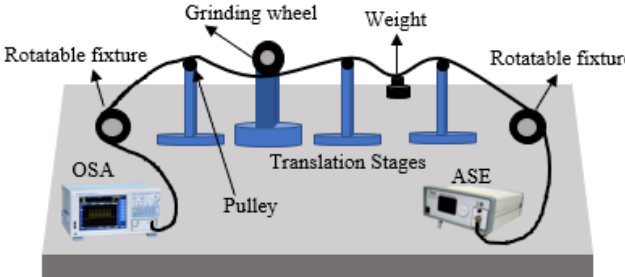
Figure 3. Fiber side-polished system diagram.